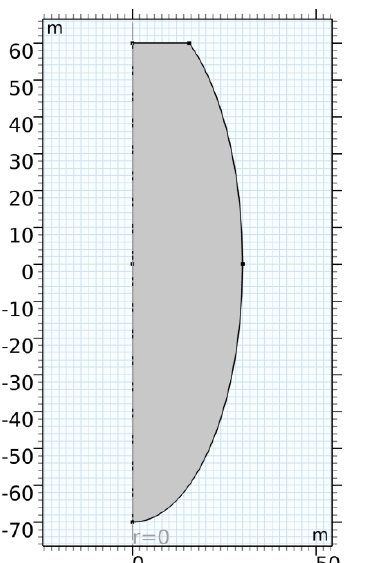
Figure 11. Models of different sizes.